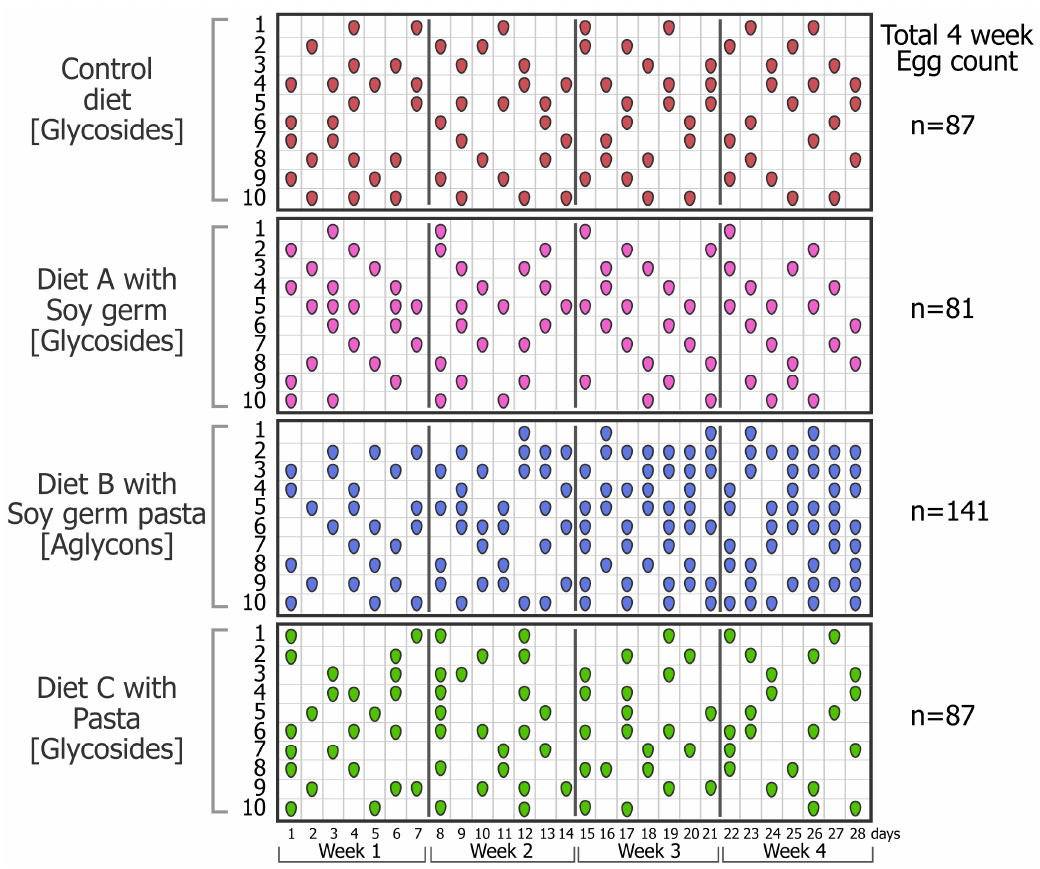
Figure 1. An “egg-array” depicting the daily laying performance of each hen ( n = 10/group) moni- tored over the 28-d period for aging White Leghorn hens fed a commercial corn/soymeal diet (Control), the same diet supplemented with soy germ to increase the isoflavone glycoside content (diet A), the same diet with added milled soy germ pasta containing predominantly isoflavone aglycons (diet B) and the same diet with added milled commercial pasta lacking isoflavones (diet C). The grid depicts each day an egg was laid by the individual hens within the diet group.